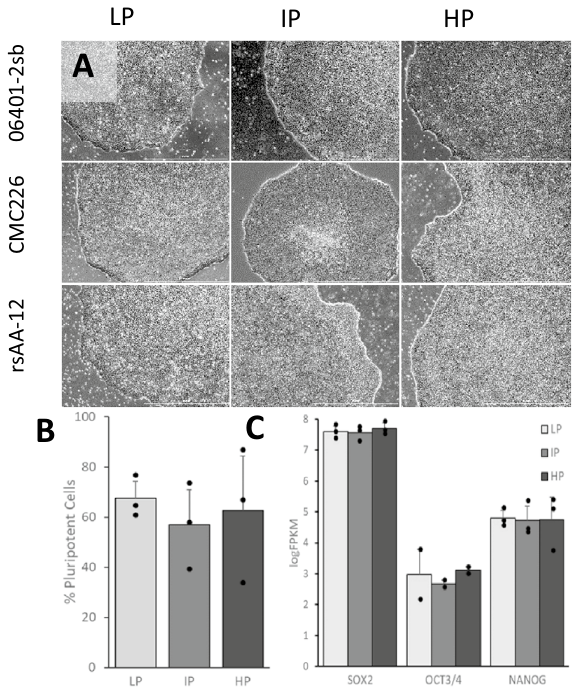
Figure 1. Morphology and pluripotency of the three iPSC lines (06401-2sb, CMC226, rsAA-12) at different passage numbers (low, intermediate, and high). ( A ) Phase-contrast images of three iPSC cell lines at different passage numbers. Scale bar = 1000 microns. ( B ) The average proportion of pluripotent cells in iPSCs at different passage numbers based on measurements of the expression of Sox2, Oct3/4, and Nanog using flow cytometry. ( C ) The expression level of SOX2 , OCT3/4 , and NANOG in iPSCs at different passage numbers based on RNA- seq. LP = low-passage, IP = intermediate-passage, HP =